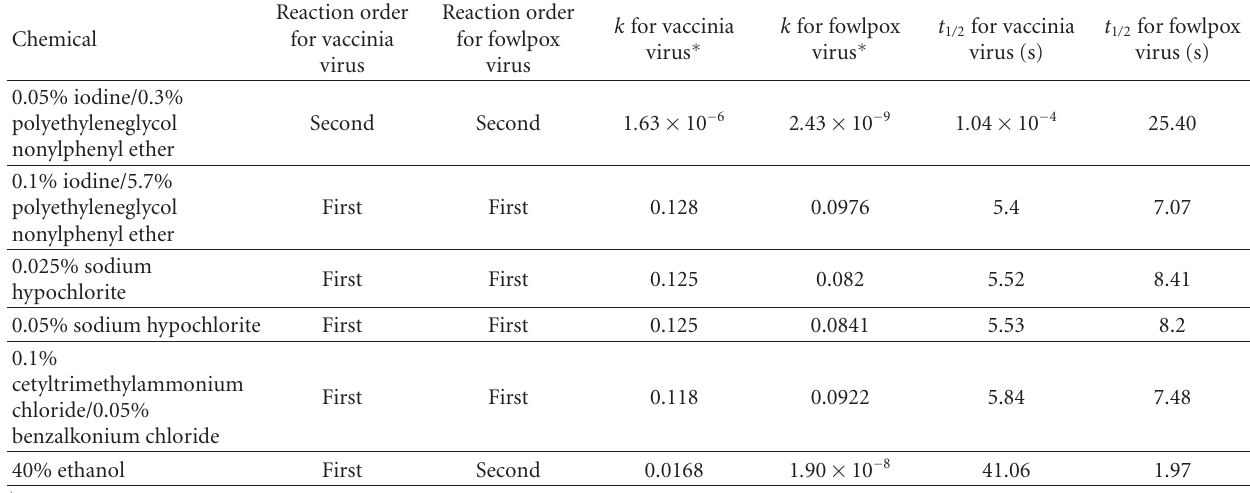
Table 3: Reaction orders, rates, and virus half-life for vaccinia and fowlpox virus following treatment with low concentrations of four